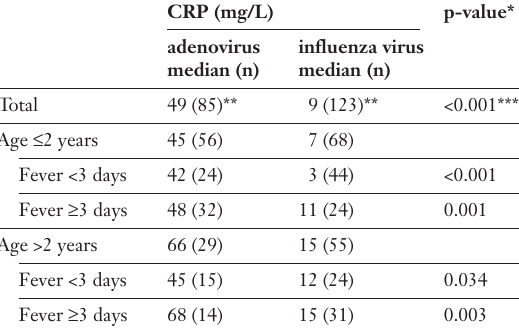
Table 3 Serum CRP in chil- dren with adenovirus or influenza virus infection, stratified according to age and duration of